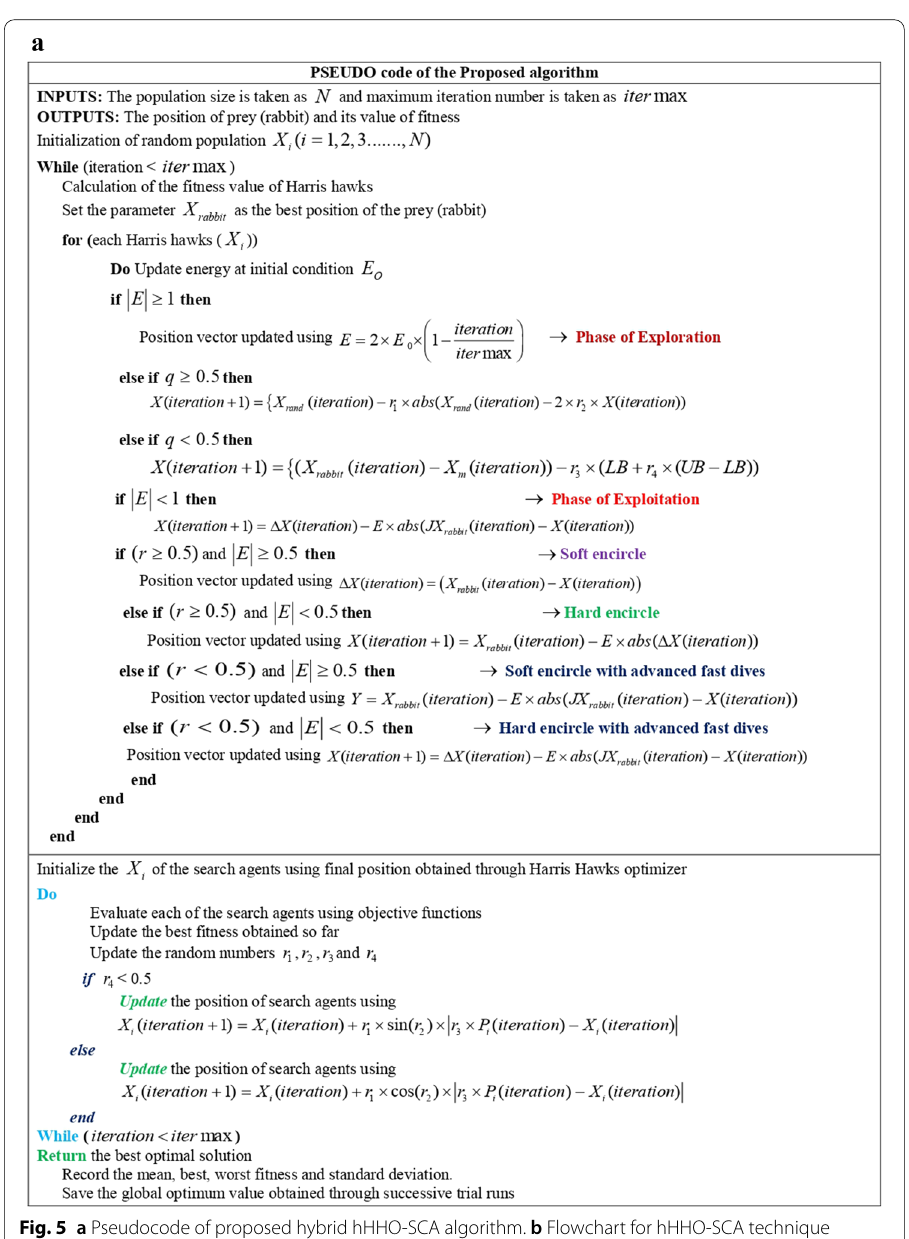
Fig. 5 a Pseudocode of proposed hybrid hHHO-SCA algorithm. b Flowchart for hHHO-SCA